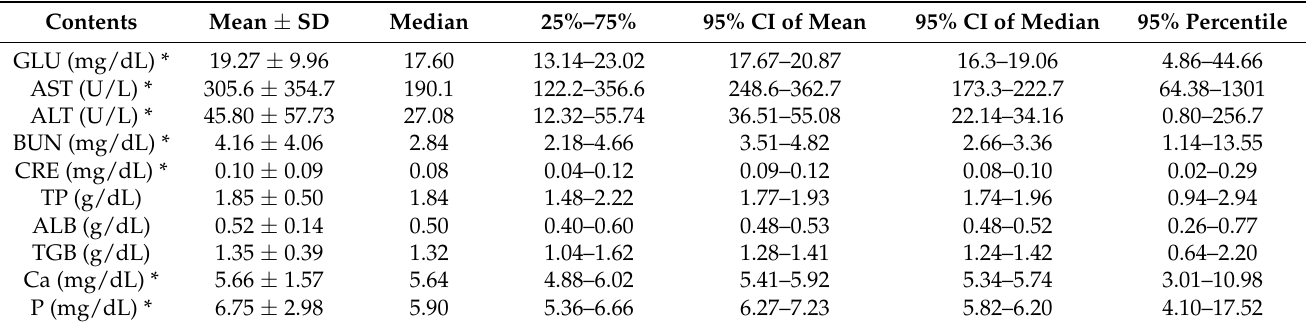
Table 2. The mean ± standard deviation (SD), median, first (25%) to third (75%) quantile range, 95% confidence interval (CI) of the mean and median, and 95% percentile (2.5%–97.5% range) of ten serum components from 151 black-spotted pond frogs: glucose (GLU), aspartate aminotransferase (AST), alanine aminotransferase (ALT), blood urea nitrogen (BUN), creatinine (CRE), total protein (TP), albumin (ALB), total globulin (TGB), calcium (Ca), and phosphorus (P). The asterisk (*) represents the components that are not normally